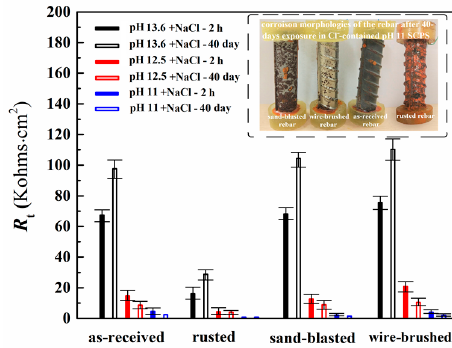
Figure7. Fitted R t valuesoftherebarintheCl − -containingSCPSofdi ff erentalkalinityfordi ff erenttimes. Figure 7. Fitted R t values of the rebar in the Cl − -containing SCPS of different alkalinity for different times.